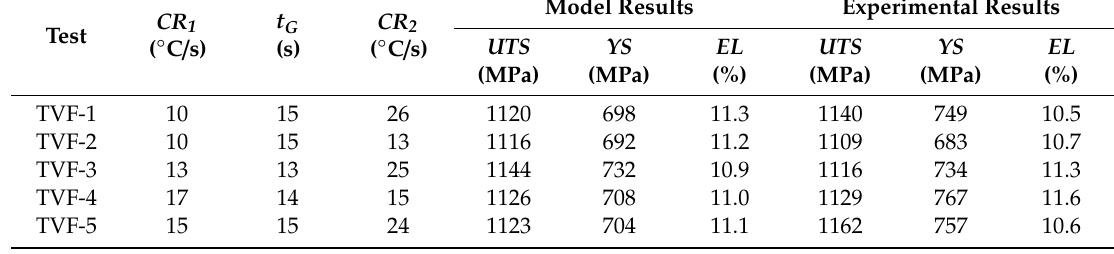
Figure 4. Pareto front for the results of multi-objective optimization. Table 8. Results of the multi-objective optimization using the models.